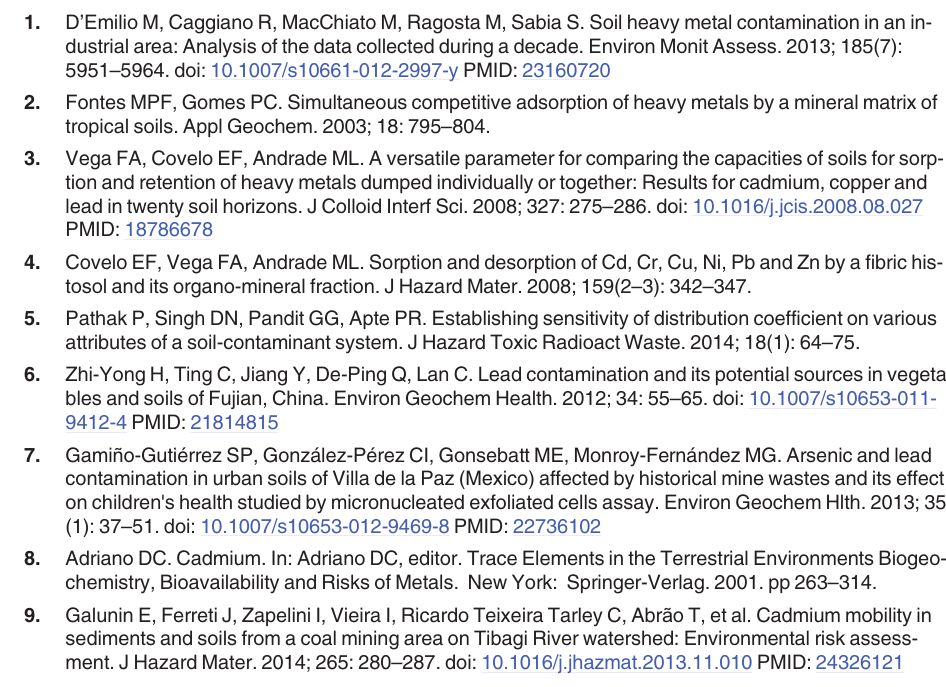
S1 Fig. X ray diffractograms of clay fraction for all horizons. (TIF) S2 Fig. BET isotherms for all horizons (TIF)